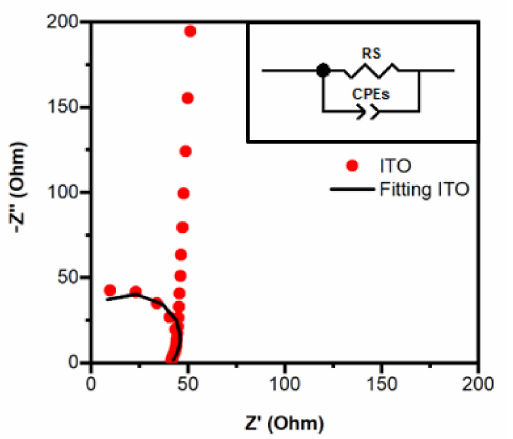
Figure 8. Nyquist plot and electrical equivalent circuit for the ITO